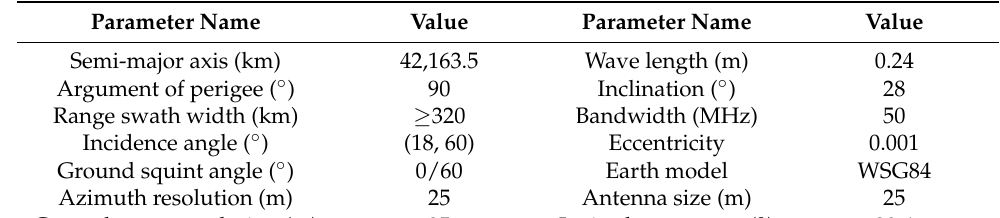
Table 3. Simulation parameters.